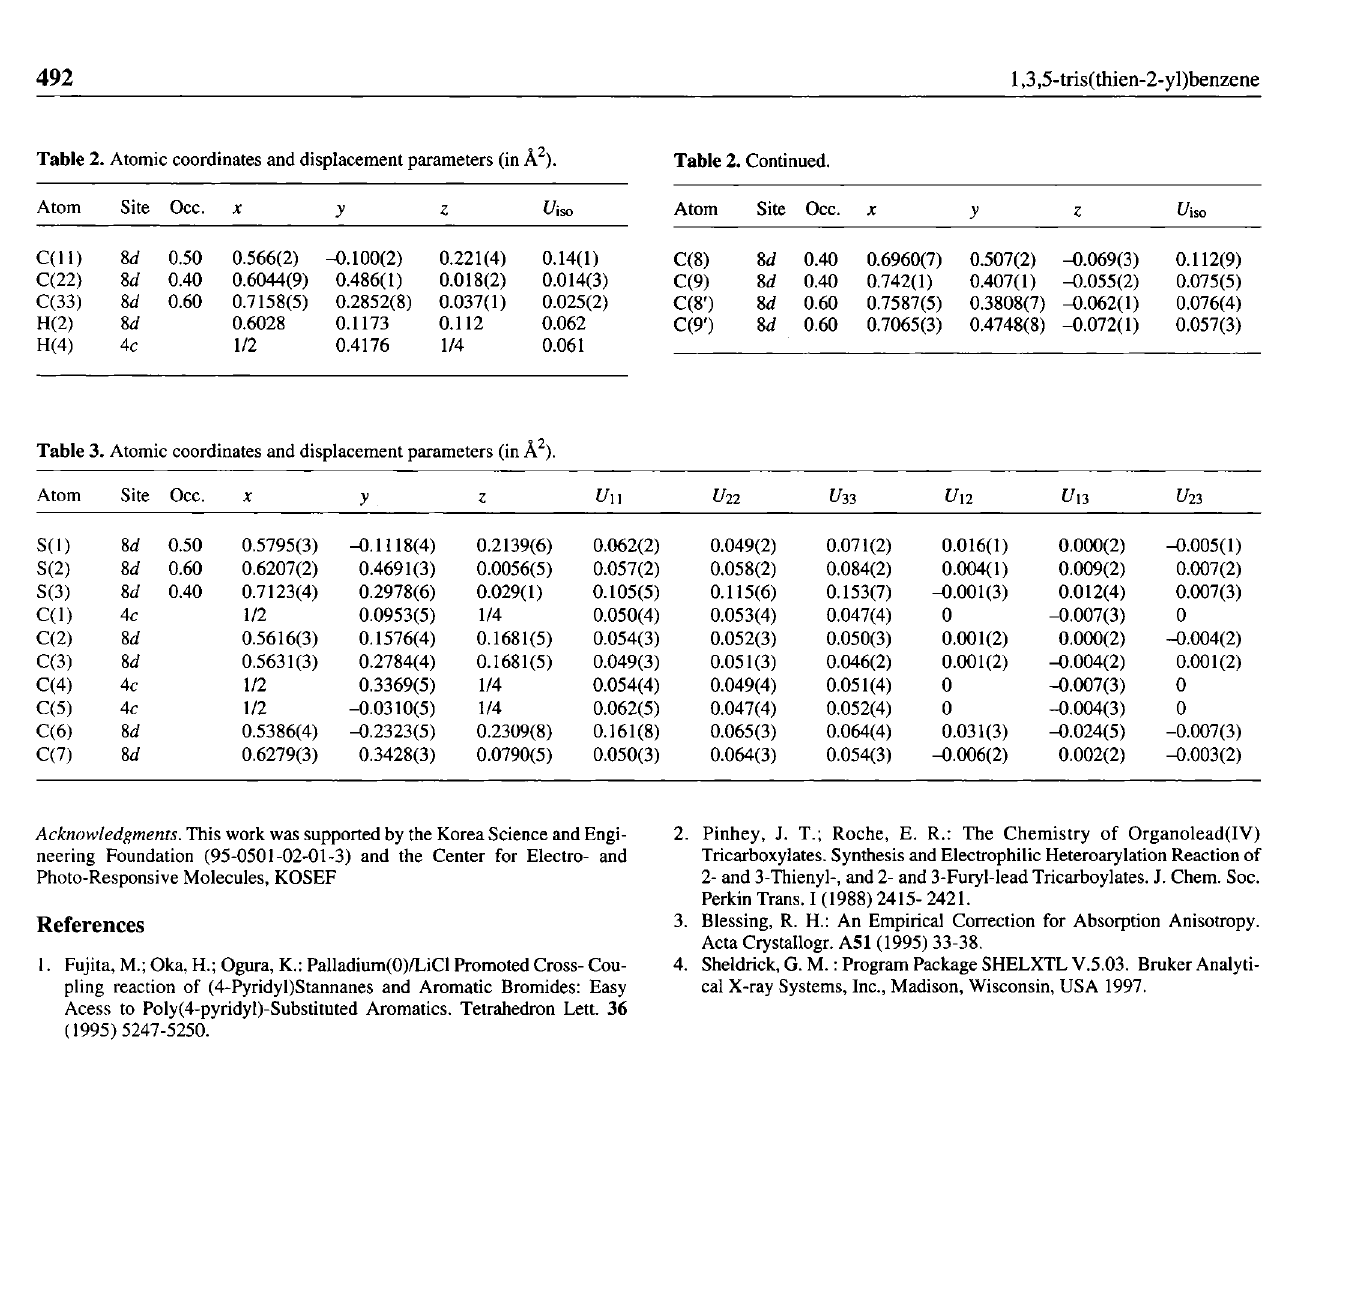
Table 2. Atomic coordinates and displacement parameters (in À 2 ). Table 2. Continued.